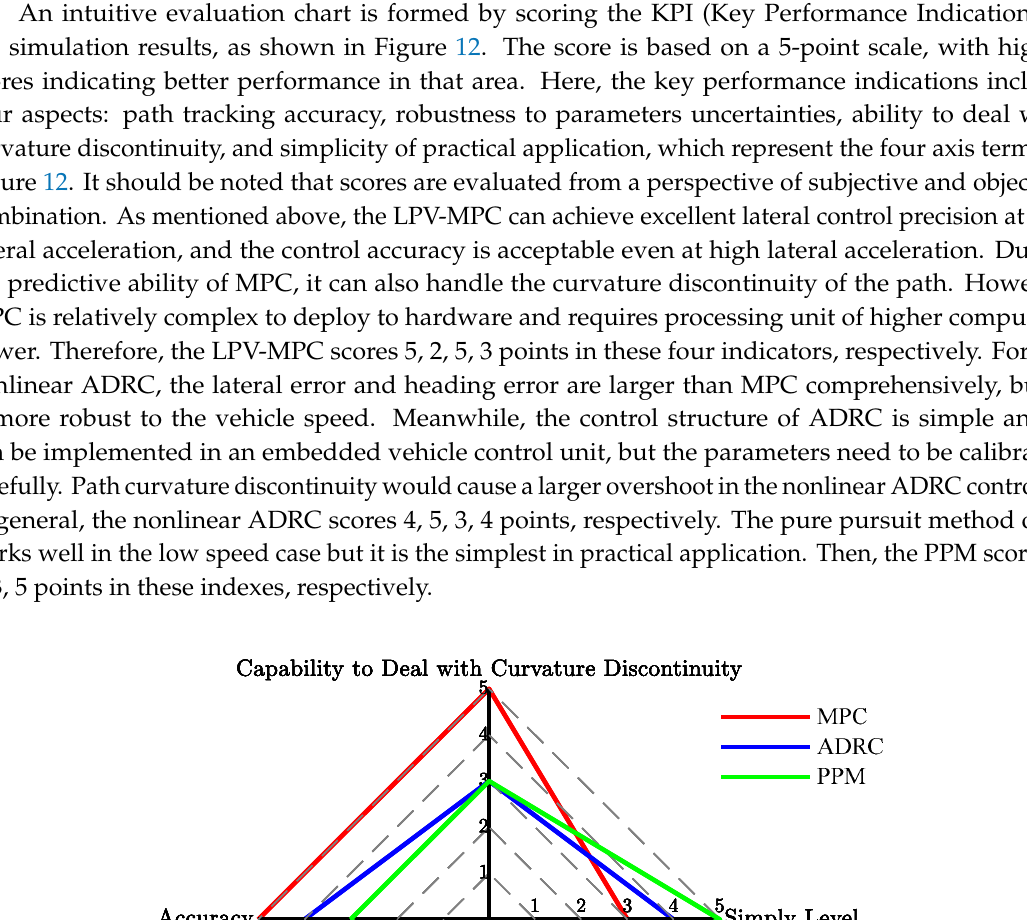
21 of 24 Table 3. Comparison of the lateral control strategies. Controller Design